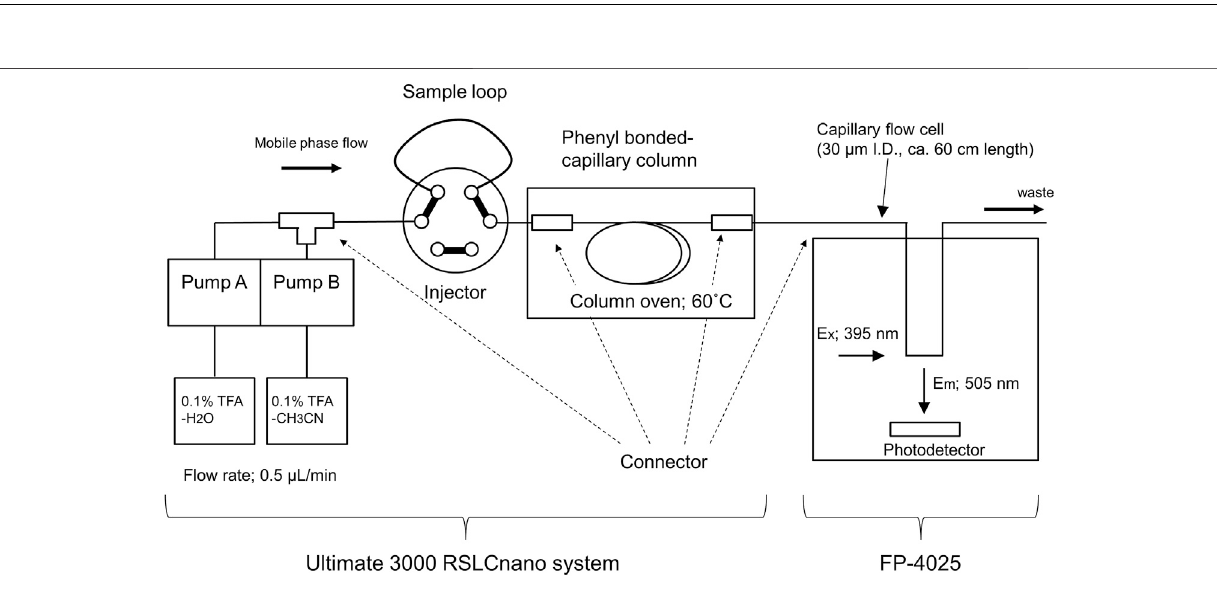
FIGURE 5 | Schematic diagram of the developed nano- fl ow FD-LC